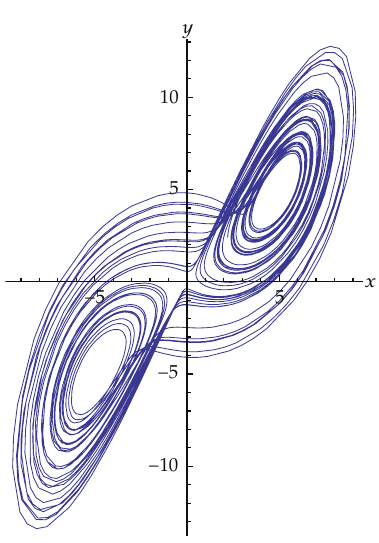
Figure 3: xy -phase portrait for α (cid:8) 0 .